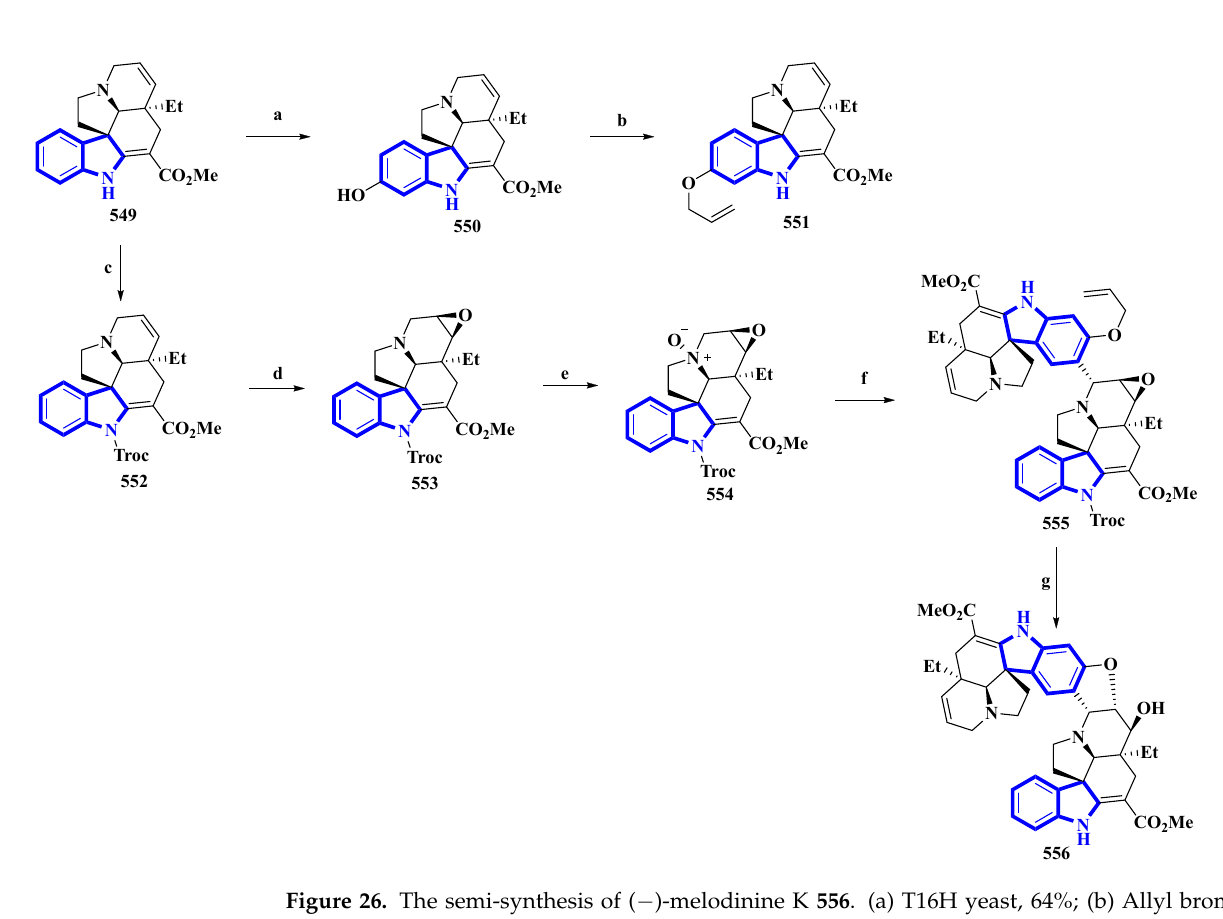
27 of 46 Figure 25. Synthesis of fradcarbazole A derivatives 535 to 548 . (a) Boc 2 O, Et 3 N, THF, 10 °C, 83–99%; (b) DDQ, THF/H 2 O 0 °C, 58–81%; (c) TFA, 10 °C, 72–94%; (d) Boc 2 O, Et 3 N, THF, 0 °C, 76%; (e) NBS, CH 3 OH, DCM, 0 °C, 94%, or NCS, CH 3 OH, DCM, rt, 48%; (f) TFA, DCM, 0 °C, 50–93%; (g) TCDI, Et 3 N, DCM, rt, 71–88%; (h) TCDI, Et 3 N, DCM, rt, 82%; (i) CH 3 I, CH 3 CN, rt, 68–74%; (j) 504–508 , Et 3 N, DMF, rt, 38–56%; (k) (CF 3 CO) 2 O, DCM, EtOH, 0 °C, 47–81%. ( − )-Melodinine K ( 556 ), a complex bisindole alkaloid, was semi-synthesized, using ( − )-tabersonine as the starting reagent. The aspidosperma–aspidosperma-type alkaloid was isolated from the Melodinus tenuicaudatus plant in 2010. Its cytotoxicity was tested by the same group and was reported to be more potent than cisplatin and vinorelbine in four of the five cancer cell lines [97]. The synthetic route adopted had six steps in its most ex- tended linear sequence (eight steps overall) and afforded compound 556 with a 4% yield (Figure 26) [98]. While planning its synthesis, 556 was divided into two fragments, both of which could be synthesized from ( − )-tabersonine ( 549 ). The total synthesis of 549 was accomplished by the same group in 2013 [99]. However, this precursor was mainly iso- lated from the seeds of Voacanga africana (a small tree). It was bio-transformed into com- pound 550 using T16H yeast and allylated by allyl bromide and K 2 CO 3 in DMF, resulting